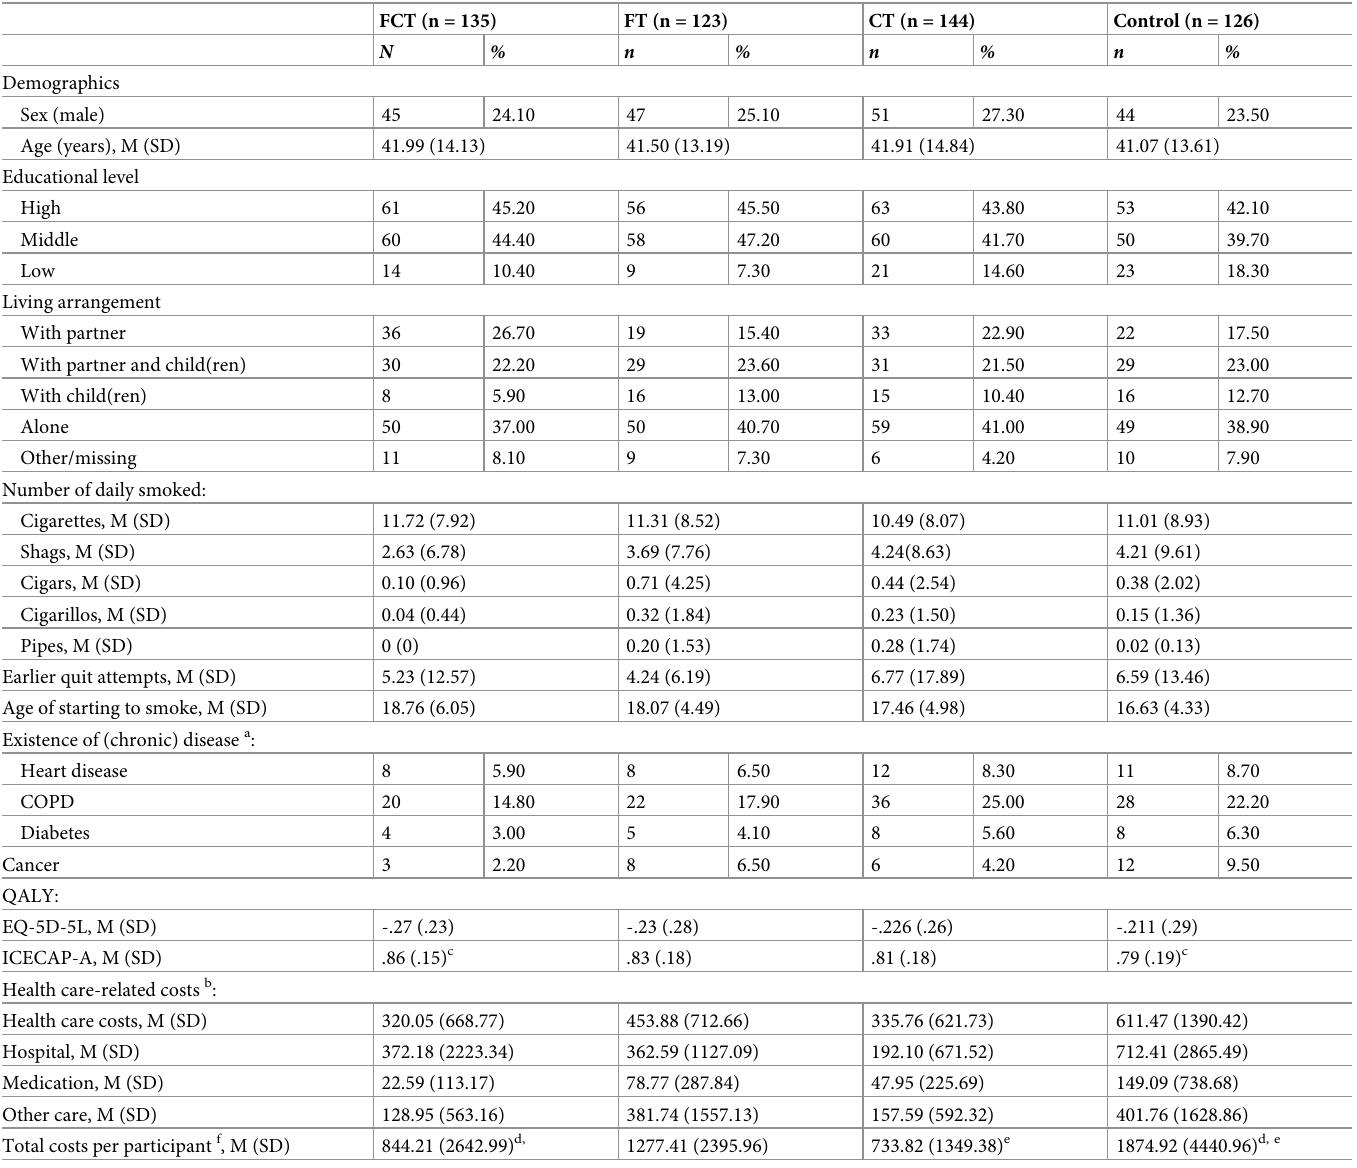
Table 1. Demographics, background variables, mean health care costs and effects per study group at